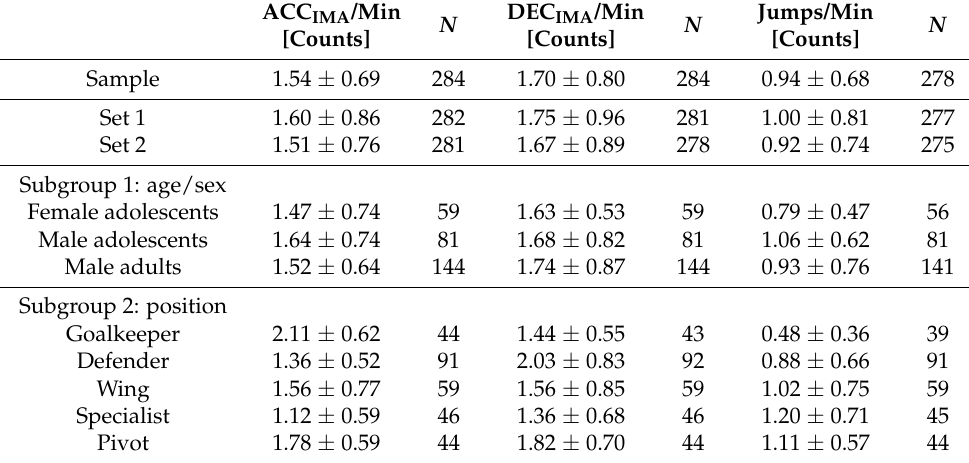
Table 4. IMA acceleration, IMA deceleration, and